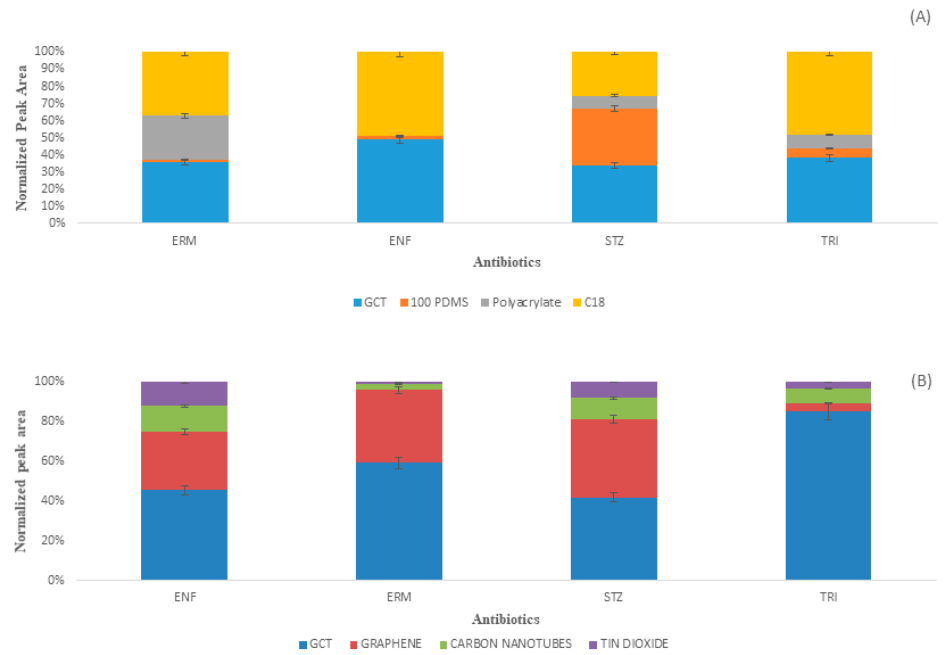
Figure 6. Comparison of extraction efficiency among ( A ) GCT components and with ( B ) different commercial fibers for the extraction of antibiotics.